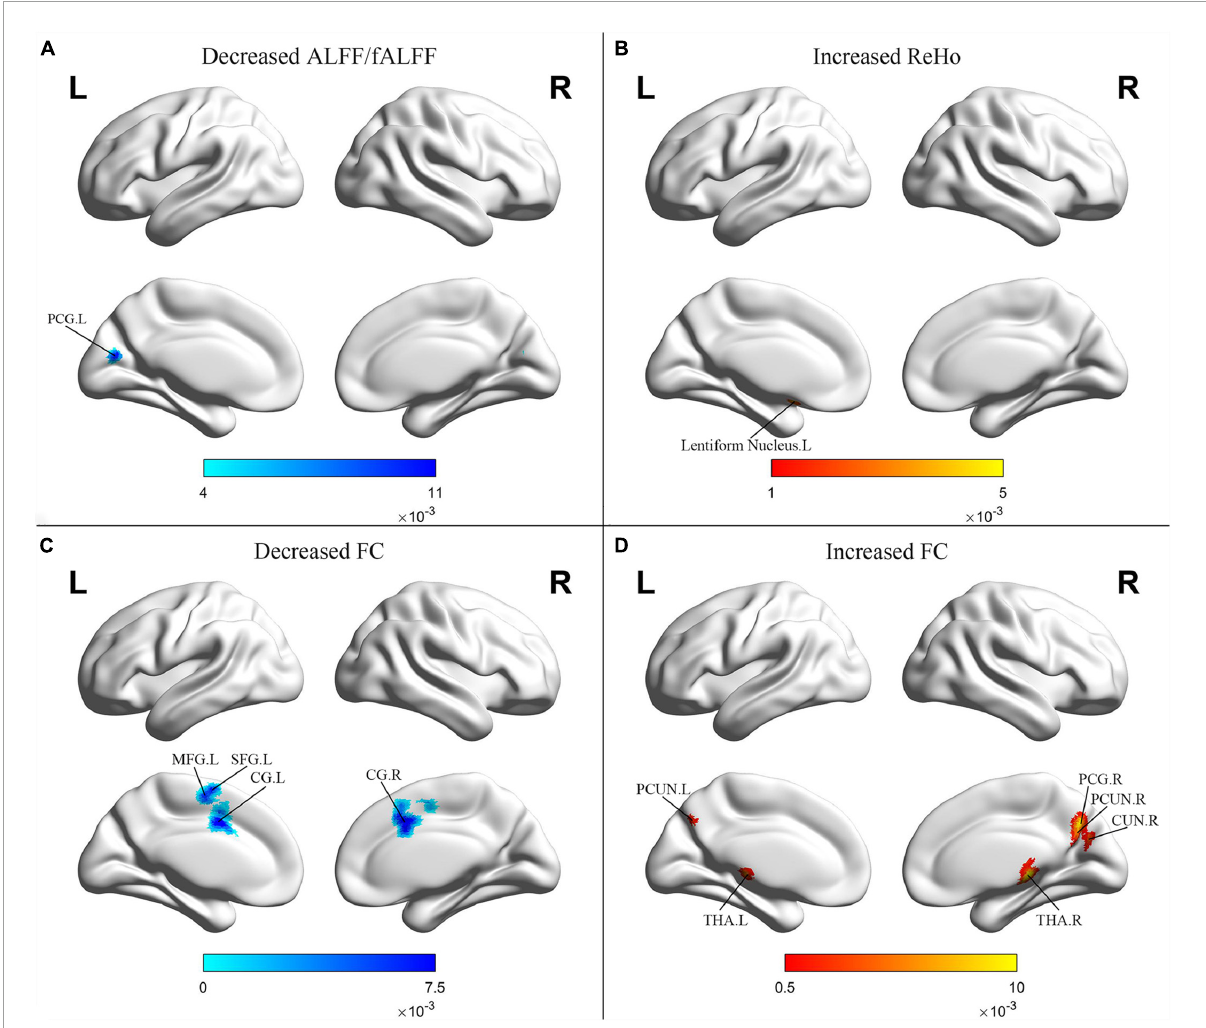
FIGURE3 Results from the activation likelihood estimation (ALE) meta-analysis of functional abnormalities in schizophrenia with PNS. Brain regions showing (A) decreased ALFF/fALFF; (B) increased ReHo; (C) decreased FC; (D) increased FC, in schizophrenia with PNS compared with HCs. Significance threshold with a false discovery rate at p < 0.01. PNS, persistent negative symptoms; HCs, healthy controls; ALFF, amplitude of low-frequency fluctuation; fALFF, fractional amplitude of low-frequency fluctuation; ReHo, regional homogeneity; FC, functional connectivity; PCG, posterior cingulate gyrus; MFG, medial frontal gyrus; SFG, superior frontal gyrus; CG, cingulate gyrus; PCUN, precuneus; THA, thalamus; CUN, cuneus; R, right; L,